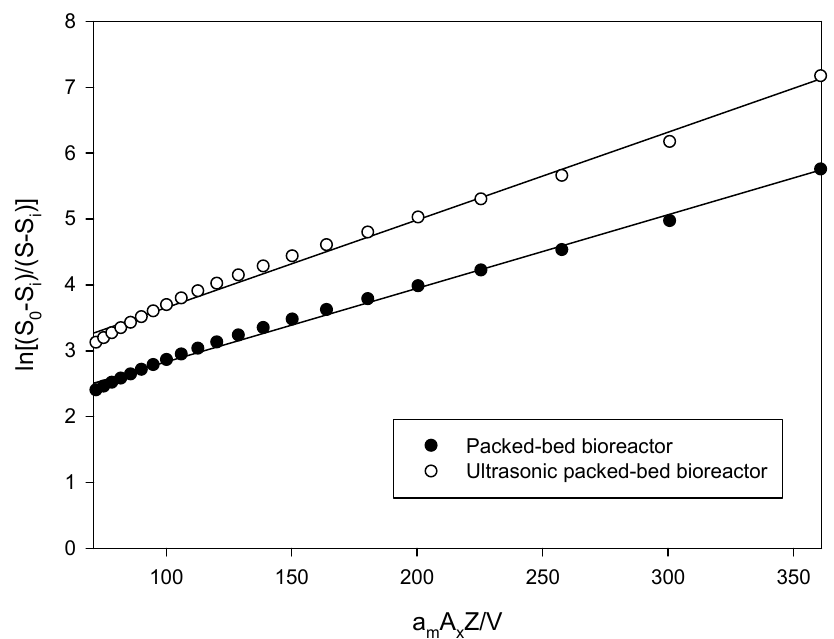
ultrasonic packed-bed (cid:35)